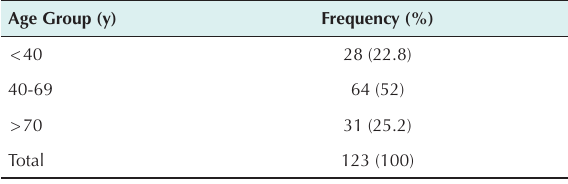
Table 2. Frequency of Patients Based on Age Group